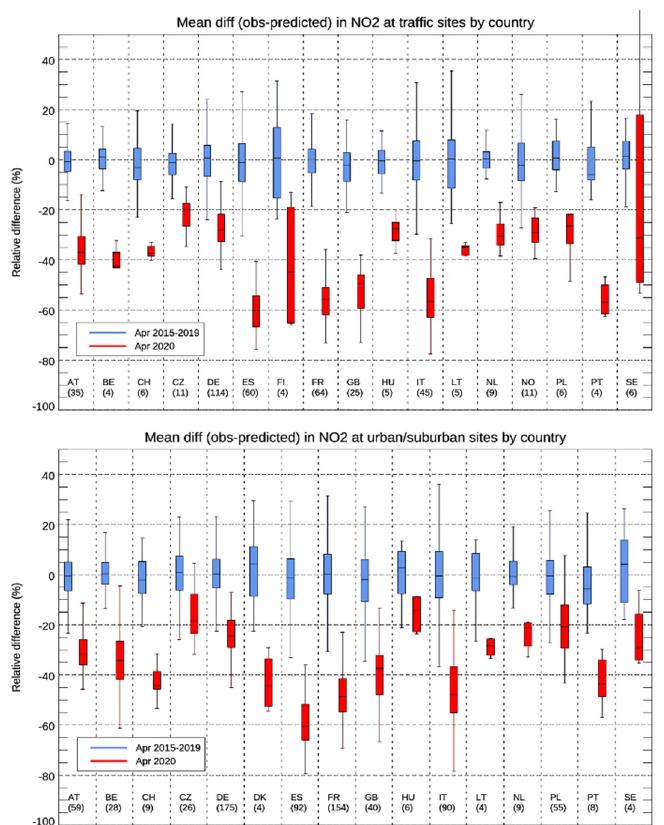
Figure 6. The country-wise differences between measured and expected mean NO 2 concentration in April 2020 for traffic sites (upper panel) and urban/suburban sites (lower panel). The numbers in brackets give the number of stations. Only countries with at least four stations in the given category were included in the figure. The centreline shows the median value while the boxes span from the 25- to 75-quantile and the whiskers from the 9- to the